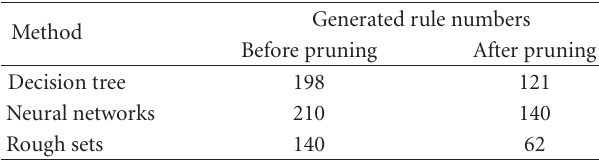
Table 9: Number of generated rules before and after pruning.